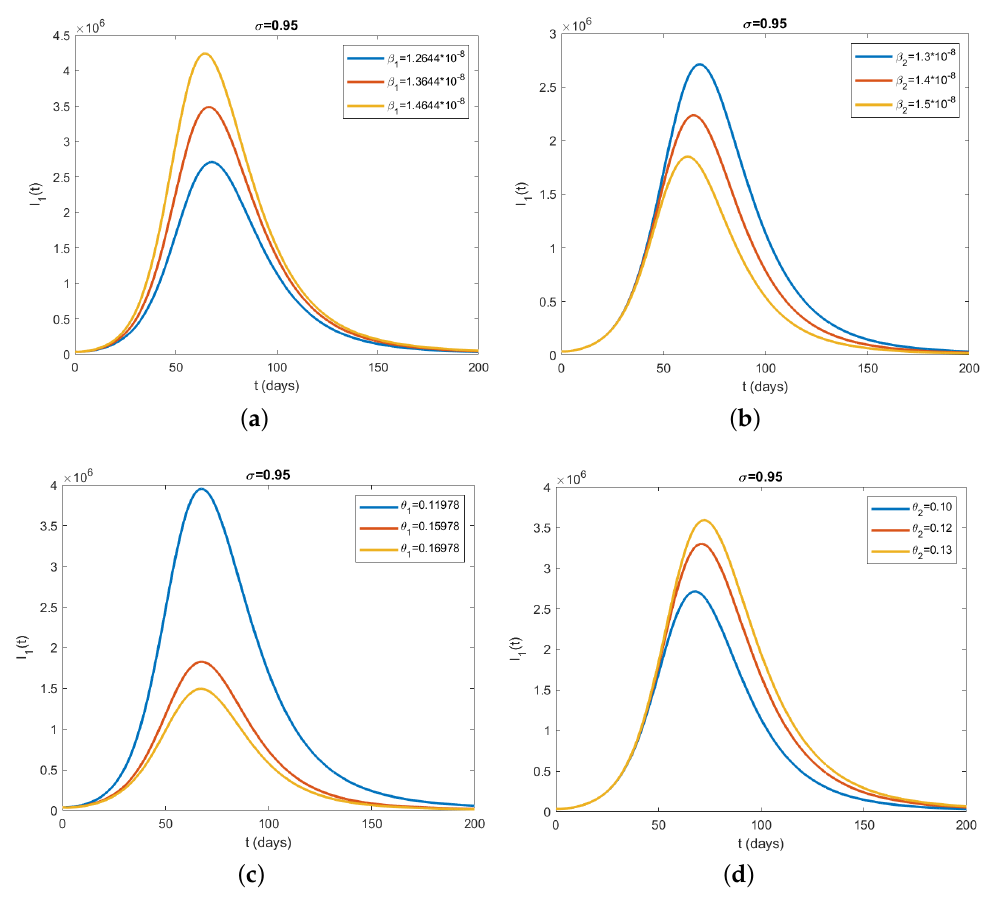
Figure 4. Effect of the model parameters ( a ) β 1 , ( b ) β 2 , ( c ) θ 1 , and ( d ) θ 2 on I 1 individuals with fractional order σ = 0.95.